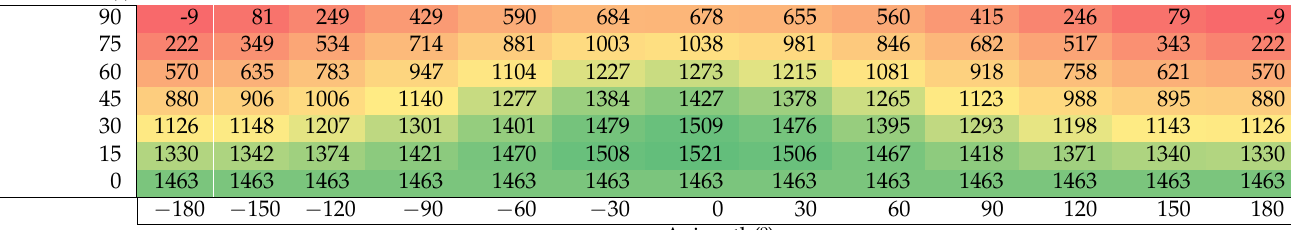
Table 7. Net Present Value NPV of a PV installation of 1000 Wp and an obstruction angle of 30 ◦ as a function of the azimuth and inclination of collectors.